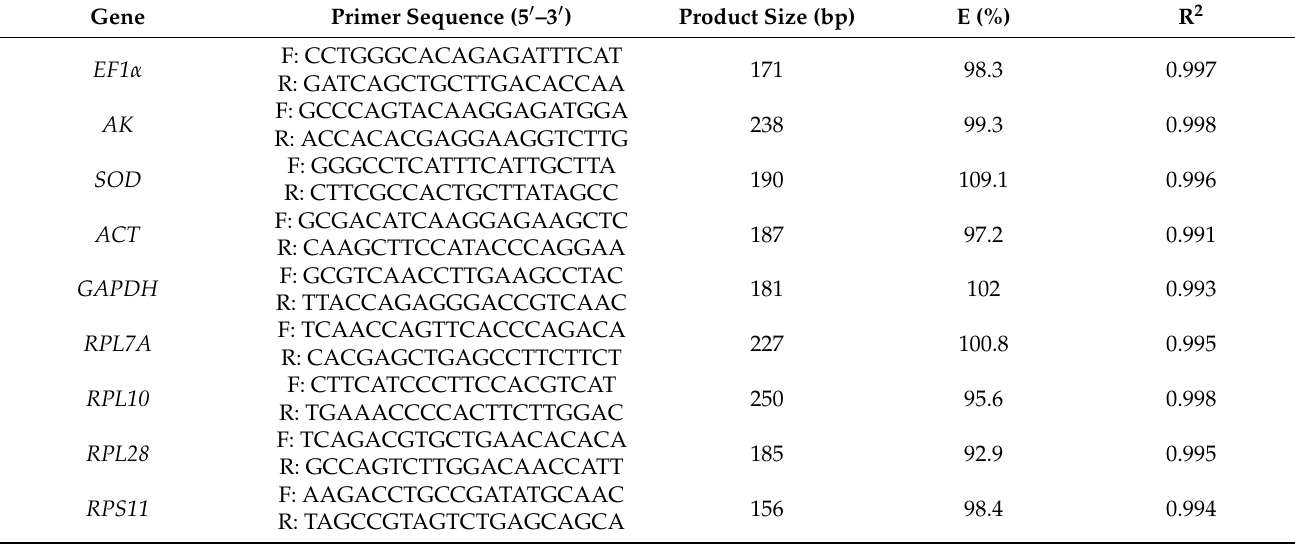
Table 2. Primers of reference genes in T. absoluta